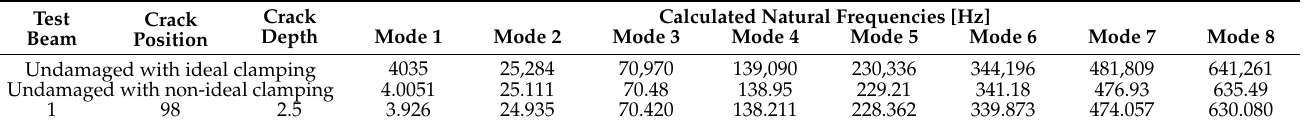
Table 16. Estimated natural frequencies.